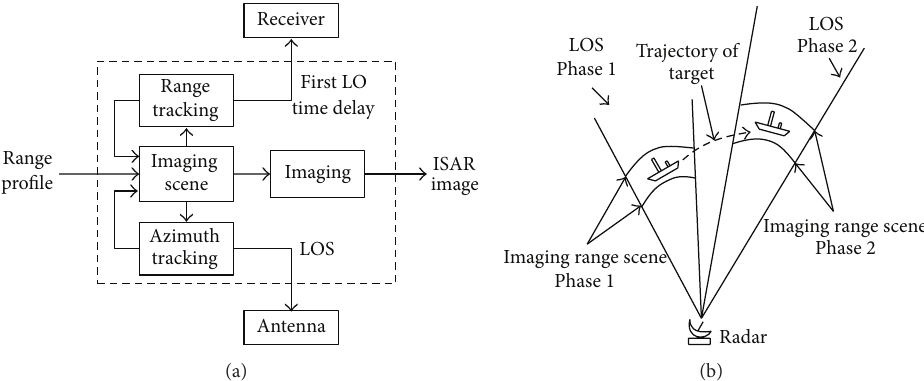
Figure 2: Principles of RAT method. (a) Basic block diagram of imaging processing with range and azimuth tracking. (b) Tracking of marine target in ISAR